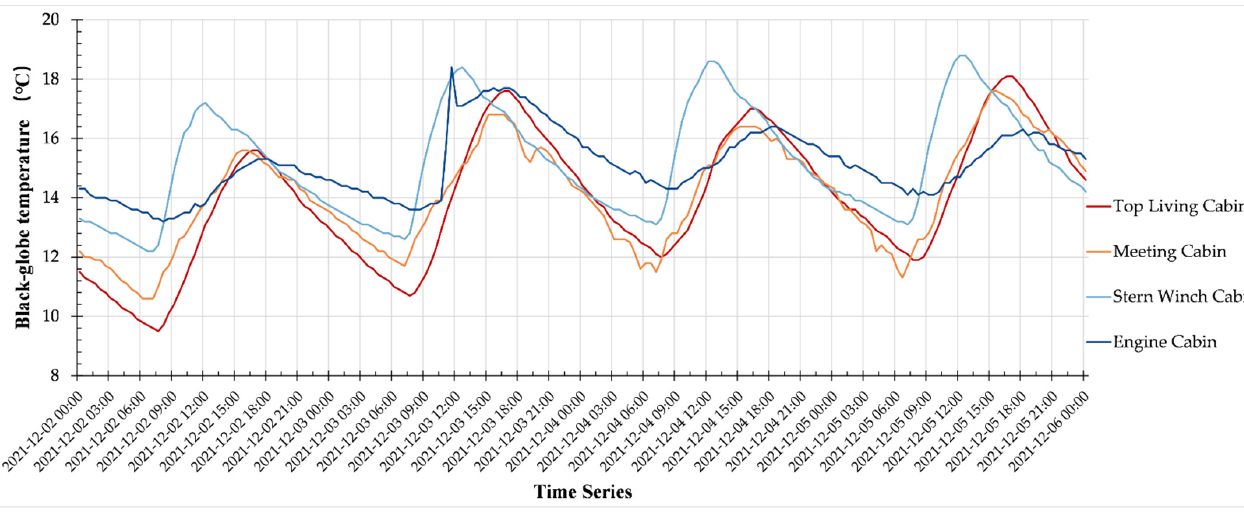
Figure 13. Black-globe temperatures in the ship from 2 to 5 December 2021.